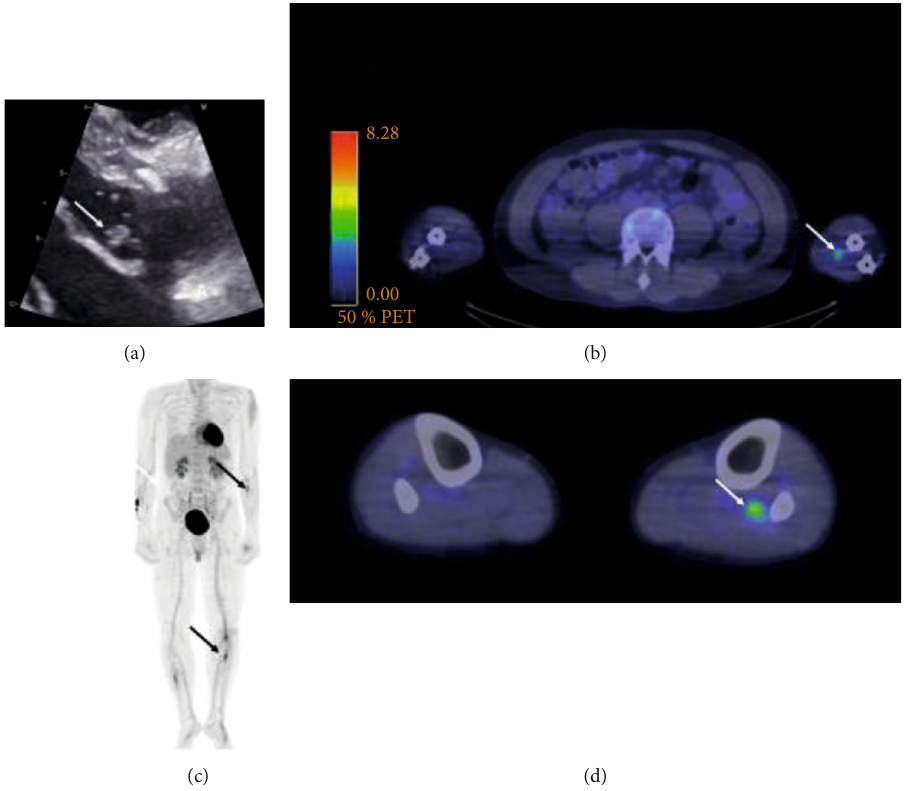
Figure 2: Transesophageal echocardiography images of patient 2 (panel (a)). Arrow shows vegetation. 18 F-FDG-PET/CT images of patient 2 (panels (b) – (d)). Arrows show 18 F-FDG uptake at the site brachial artery and fi bular Table 1: The characteristics of 7 patients with Candida spp. prosthetic valve endocarditis.